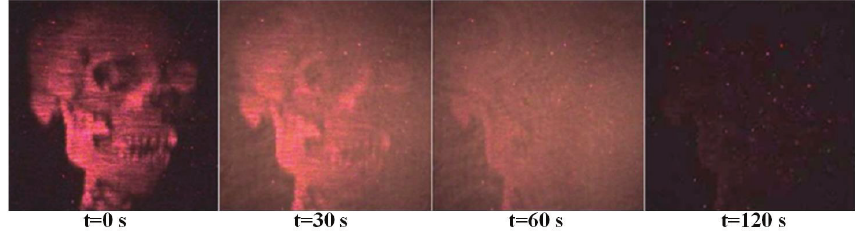
Figure 12. Images from the updatable holographic 3D display achieved by Peyghambarian’s group. (Reprinted with permission from ref [62], [Springer Nature]).